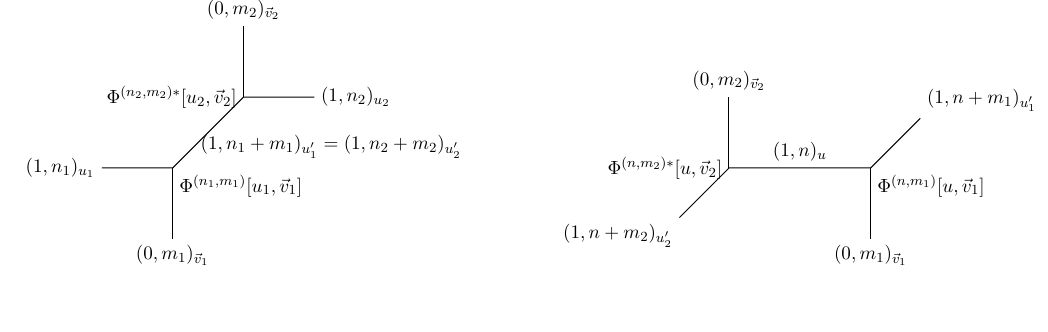
Figure 5 . (cid:5) ( n 1 ;n 2 ;m 1 ;m 2 ) [ u 1 ;~v 1 ; u 2 ;~v 2 ] and (cid:5) ( n;m 1 ;m 2 ) (cid:3) [ u 1 ;~v 1 ;~v 2